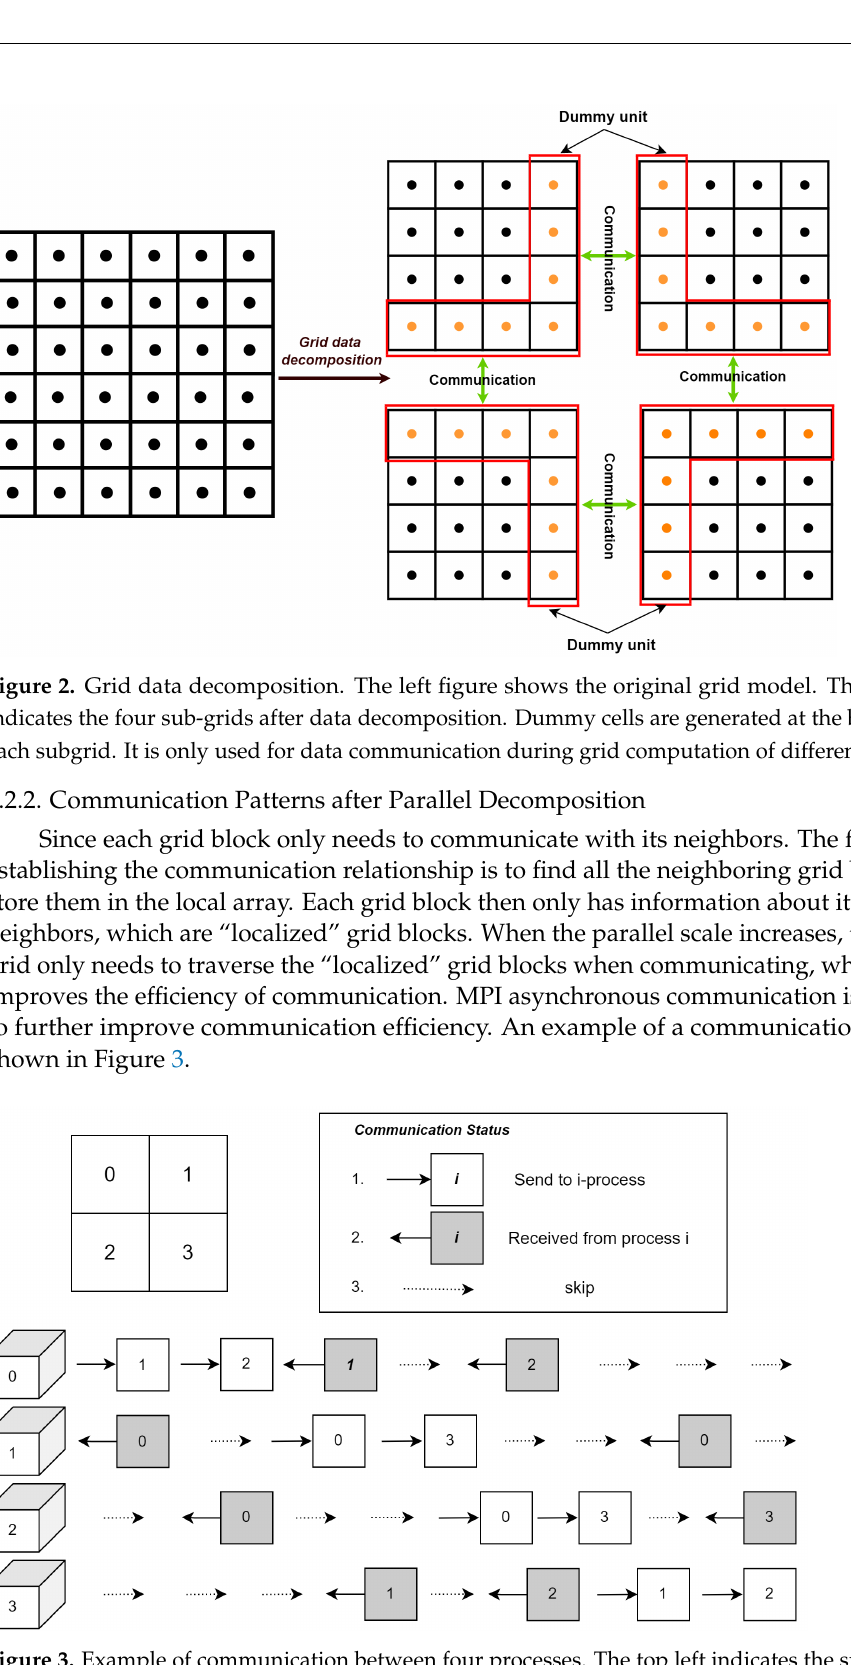
Figure 3. Example of communication between four processes. The top left indicates the subgrid to be calculated. The upper right indicates the three different process states during communication. The bottom indicates the state of each process at the same time step. Note that each process performs a time step of computation after receiving data, hence